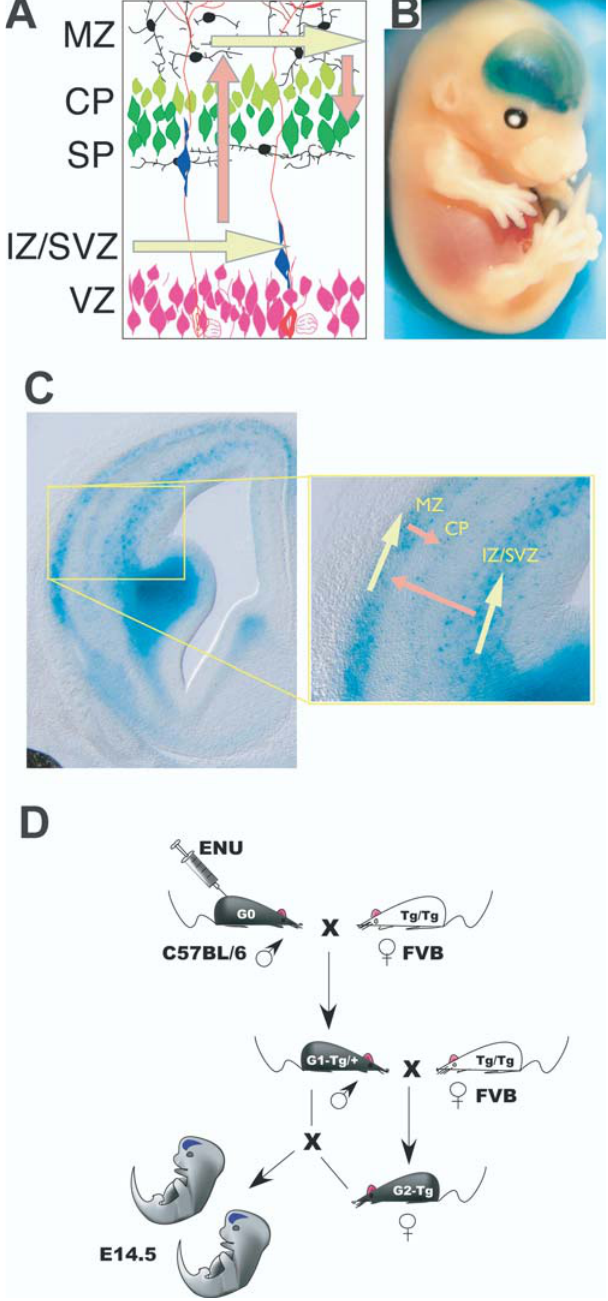
Figure 1. The Strategy for Isolation of Recessive Mutations Disrupting Cortical Development (A) Migrating interneuron precursors appear to migrate tangentially (yellow arrows) through both the MZ and the IZ/SVZ. Precursors also migrate radially (pink arrows) to reach the developing cortical plate (CP). (B) Migrating interneuron precursors expressing b -galactosidase can be seen in a whole-mount preparation of an E14.5 Dlx-LacZ mouse as diffuse cortical staining. (C) In coronal section, the densely labeled SVZ of the LGE can be seen, as can the streams of migrating interneuron precursors in the cortex. (D) To identify recessive mutations, male C57BL6/J mice were treated with ENU and then crossed to FVBN/J females that were homozygous for the Dlx-LacZ transgene. Male offspring of this cross were PLoS Biology |